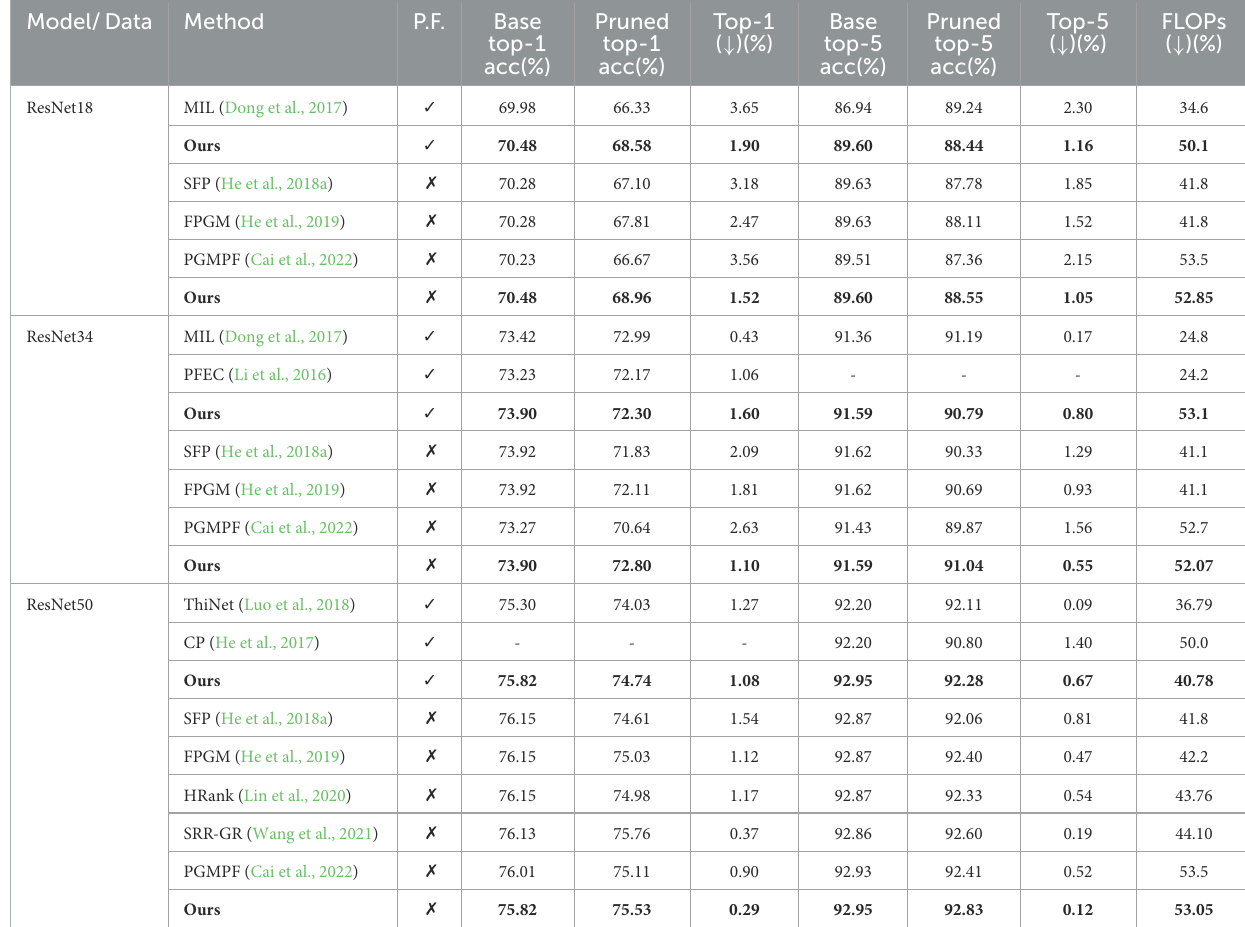
TABLE 4 Comparison of pruned ResNet on